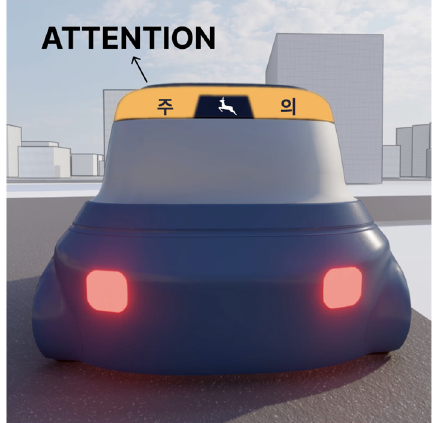
Figure 9. “ Deer crossing” sign symbol plus text “ATTENTION” wri tt en in Korean. Figure 9. “Deer crossing” sign symbol plus text “ATTENTION” written in